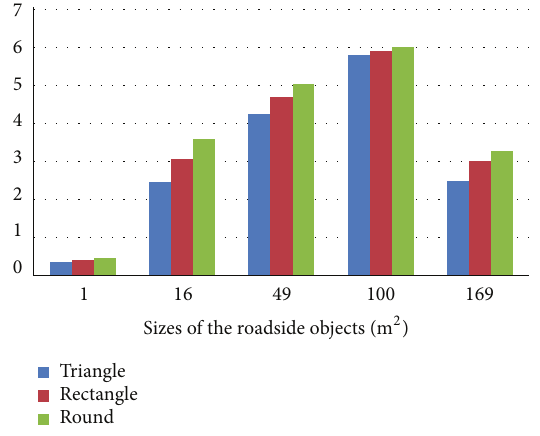
Figure 9: The comfort assessment of the roadside objects under 120 km/h.